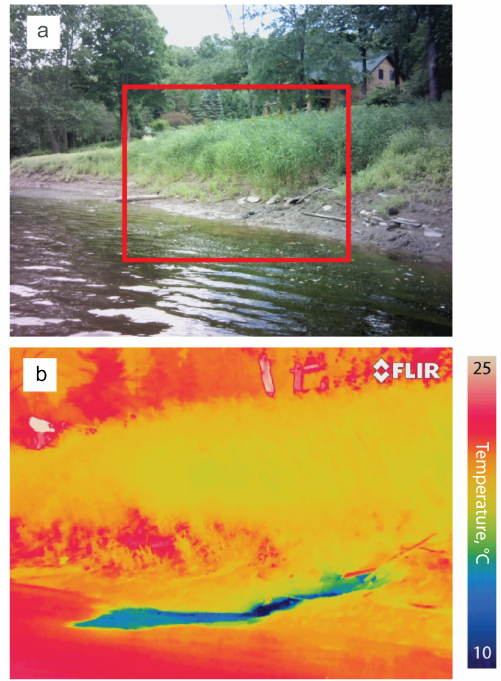
Figure 5. (a) Photograph of riverbank at site 2 with red rectangle in- dicating area of infrared image (b) . Color infrared image with blue area showing colder groundwater entering the river. Color scale in- dicates temperature, in ◦